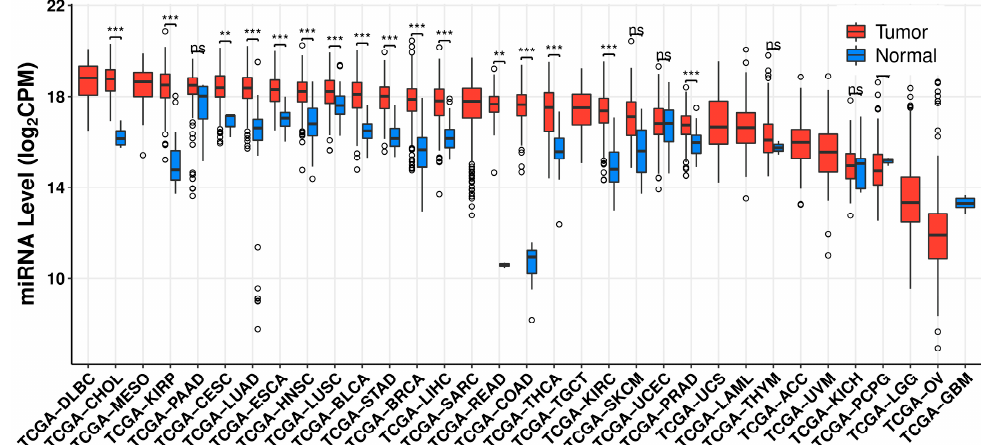
Figure 3. CancerMIRNome analysis of hsa-miR-21-5p expression in TCGA database demonstrating aberrant miR-21 expression across various cancer. Open circles indicate outliers. Some cancers (DLBC, MESO, SARC, TGCT, UCS, LAML, ACC, UVM, LGG, OV, and GBM) are incomparable in the dataset due to the lack of comparable tumor or normal samples. Significance was evaluated by CancerMIRNome via Wilcoxon rank-sum test. ** p < 0.01, *** p < 0.001, ns; not significant. DLBC—